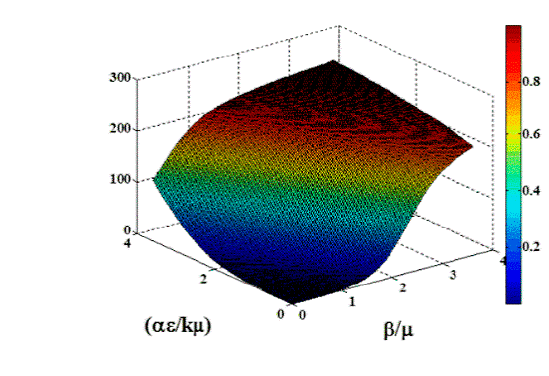
Figure 3. ( a ) Heat map of the infectious fraction as a function of R direct = epidemiological values listed in Table 1 at t = 100 days. The numerical solution at t = 100 does not match the analytical solution any more (no longer steady state). ( b ) 3D surface plot of the infectious fraction provides another view of the transition at t = 100